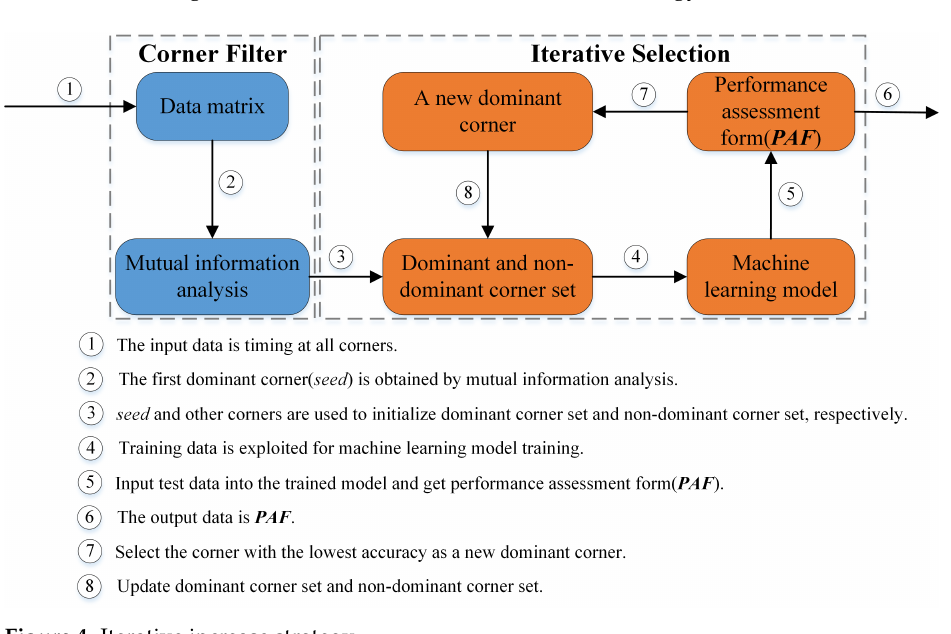
Figure 4. Iterative increase